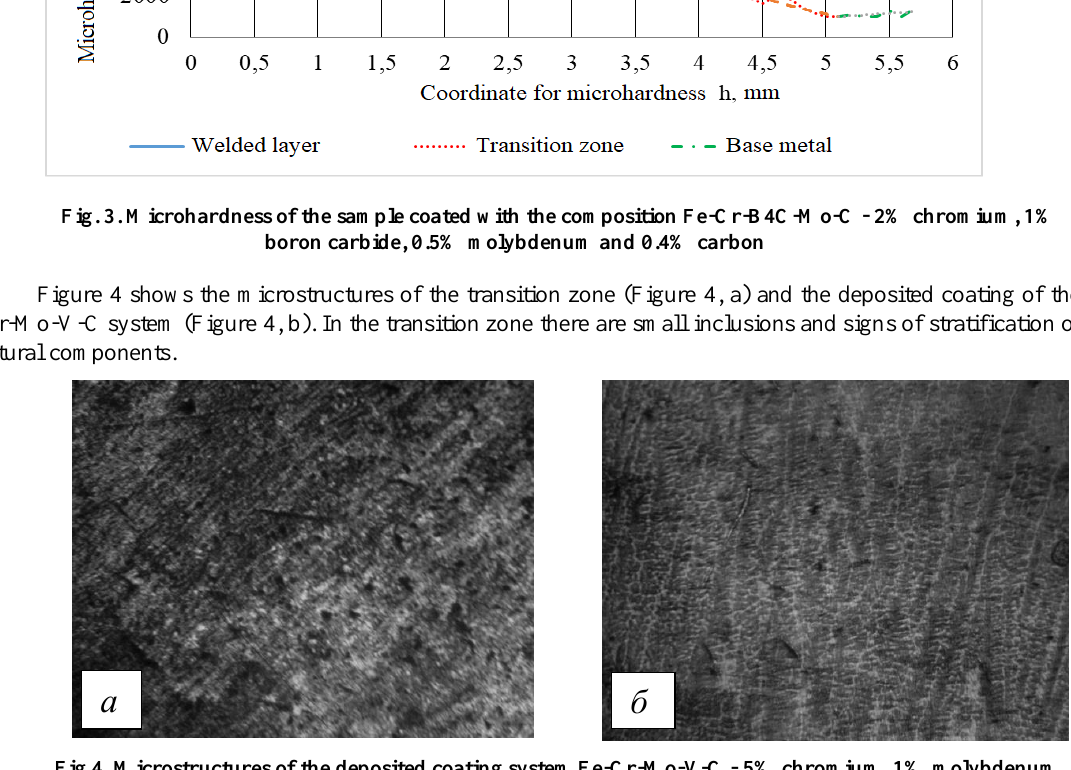
Fig.4. Microstructures of the deposited coating system Fe-Cr-Mo-V-C - 5% chromium, 1%